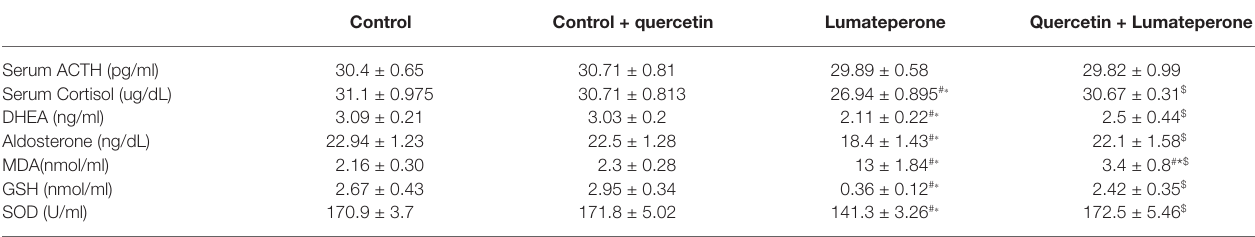
TABLE 1 | Serum ACTH, cortisol, DHEA, aldosterone, MDA, GSH, and SOD in the control, quercetin-treated, lumateperone-treated and quercetin-lumateperone- cotreated groups.